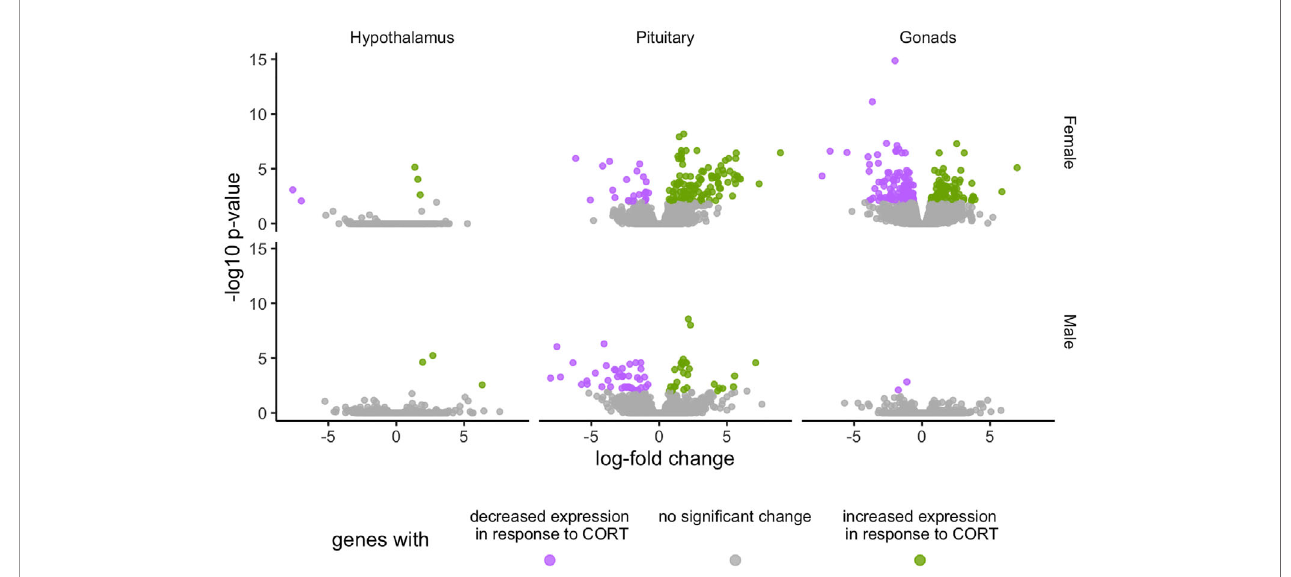
FIGURE 2 | Volcanoplots depicting total transcriptional changes of CORT-treatment group as compared to vehicle-control group.Volcanoplots represent the number of differentially expressed genes throughout the HPG axis offemales (top) and males (bottom). The x-axis represents log-fold change of differentially expressed genes andthe y-axis-statistical signi fi cance (log10 p-values where FDR<0.01). Each datapoint represents a differentially expressedgene inthe HPG axis. Signi fi cant differences in gene expression are represented ingreen (increased expression)orpurple(decreased), orgray (no signi fi cant difference) inresponse to corticosterone treatment.